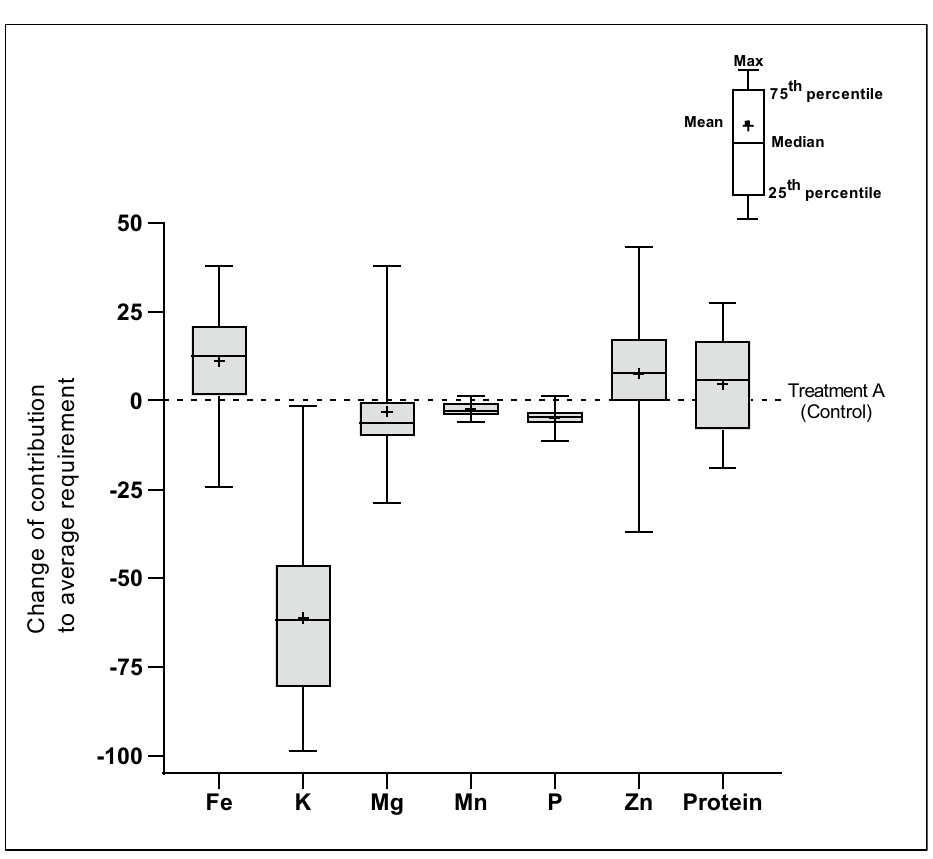
Figure 5. Contribution of average wheat supply of 298.5 g/person/day to daily average requirement of some essential nutrients of European adults (≥ 18 years). Treatment A = Ambient CO2, lower temperature settings and no O3 addition